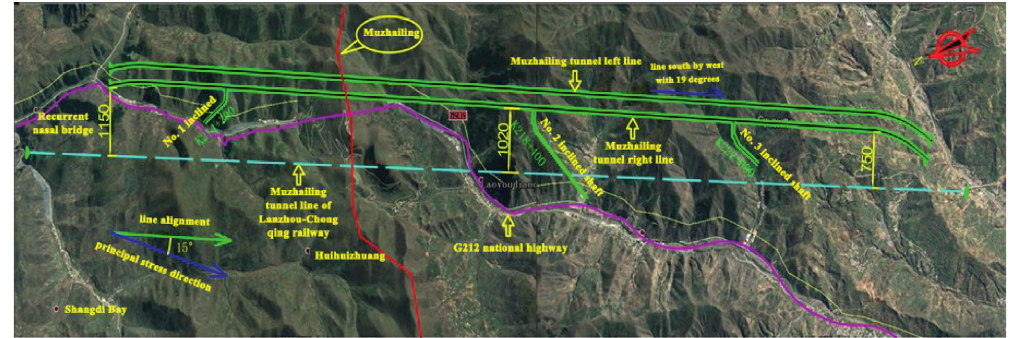
Figure 1: Geographical location of Muzhailing Tunnel.